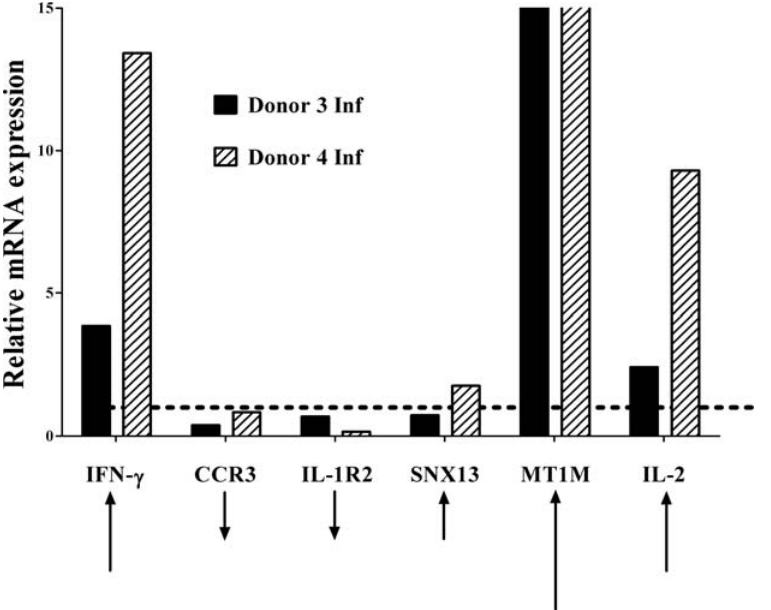
Figure 2. Validation of microarray data with TaqMan RT-PCR of selected differentially expressed genes. RNA was extracted from human MDM-T cell co-cultures 4 hours after the addition of T-cells to infected or uninfected macrophages (28 total hours of L. chagasi infection). The relative expression of genes in infected compared to uninfected levels, in two separate donors, was examined using TaqMan RT-PCR. Six genes identified to be differentially expressed in the primary microarray analysis were selected for validation. Relative expression of infected samples is displayed in reference to a line at y=1, signifying no change. Bars below y=1 signify genes that have decreased expression relative to uninfected samples. The black arrows at the bottom indicate the relative magnitude and direction of change anticipated from the microarray data.